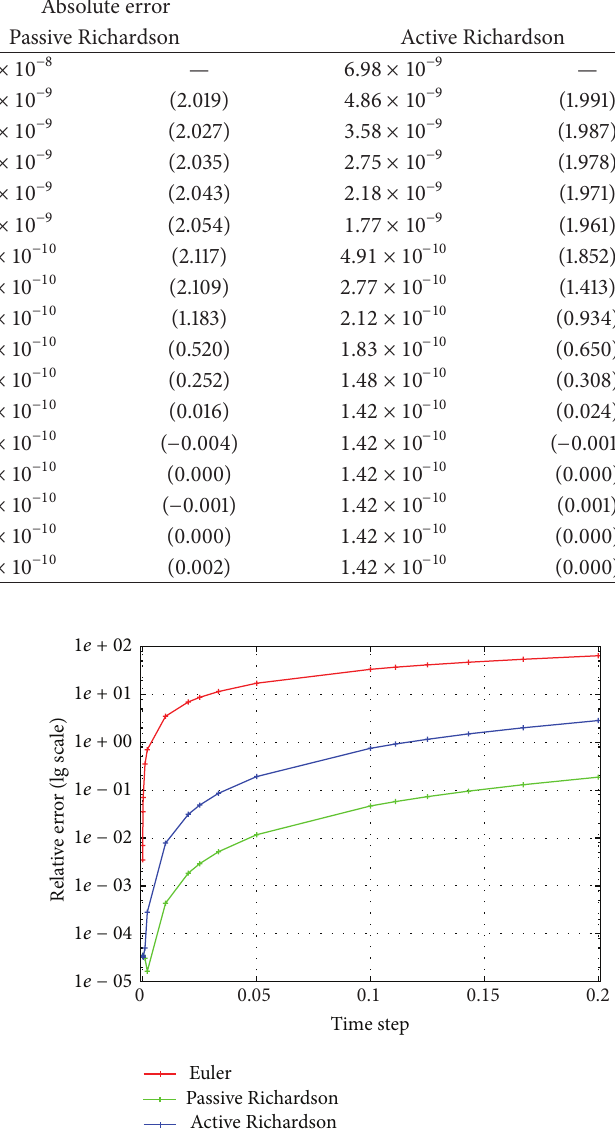
Figure 2: Absolute error as a function of time step for the Euler method without and with passive and active Richardson extrapo- lation, by grid step Δ𝑥 = 1 and coefficient 𝐷 = 1.0 . The reference solution was calculated using Δ𝑡 = 10 −7 .